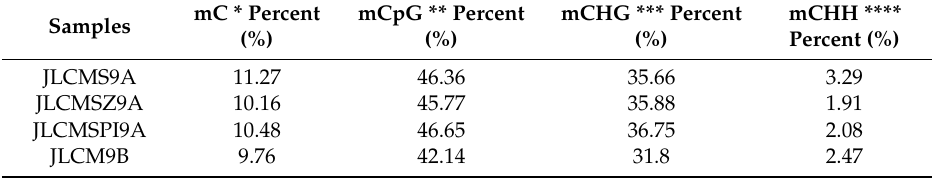
Table 2. Proportion of the di ff erent types of methylated cytosine sites in four soybean